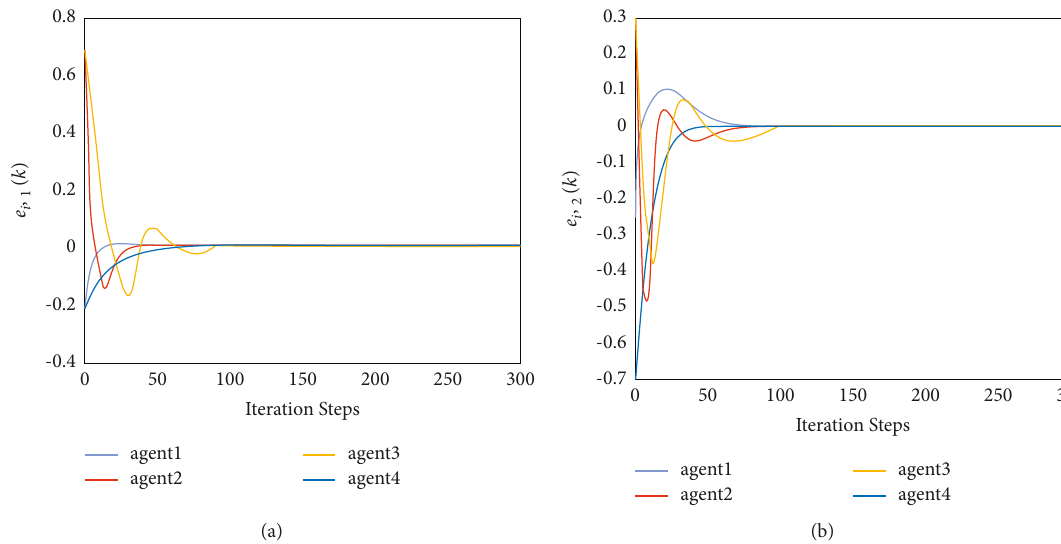
Figure 4: The evolution process of the local consistency error e of the local consistency error, e i